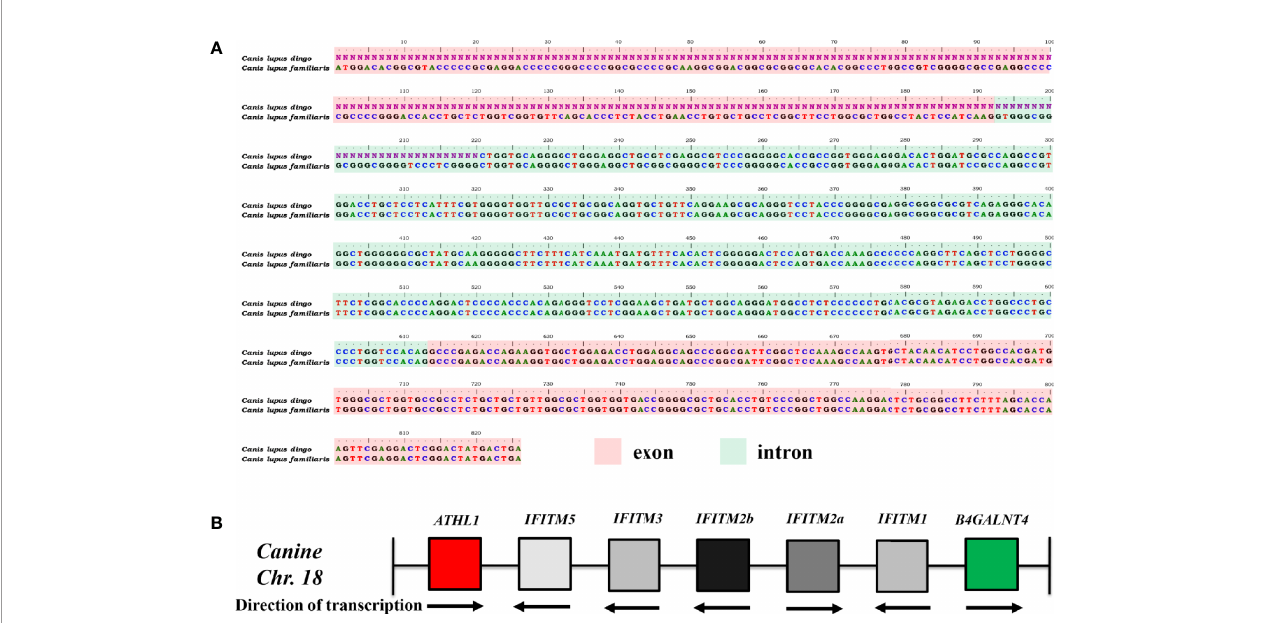
FIGURE 1 | Identi fi cation of gene locus of caIFITMs in CanFam3.1 . (A) Nucleotide alignment results of caIFITM5 gene between Canis lupus familiaris and Canis lupus dingo . The exon and intron sequences were indicated by light red and light green, respectively. Nucleotide sequences that were not determined in caIFITM5 gene in Canis lupus dingo were labeled “ N. ” (B) Organization of caIFITM locus on chromosome 18. caIFITM genes between ATHL1 and B4GALNT4 were annotated, and their direction of transcription were